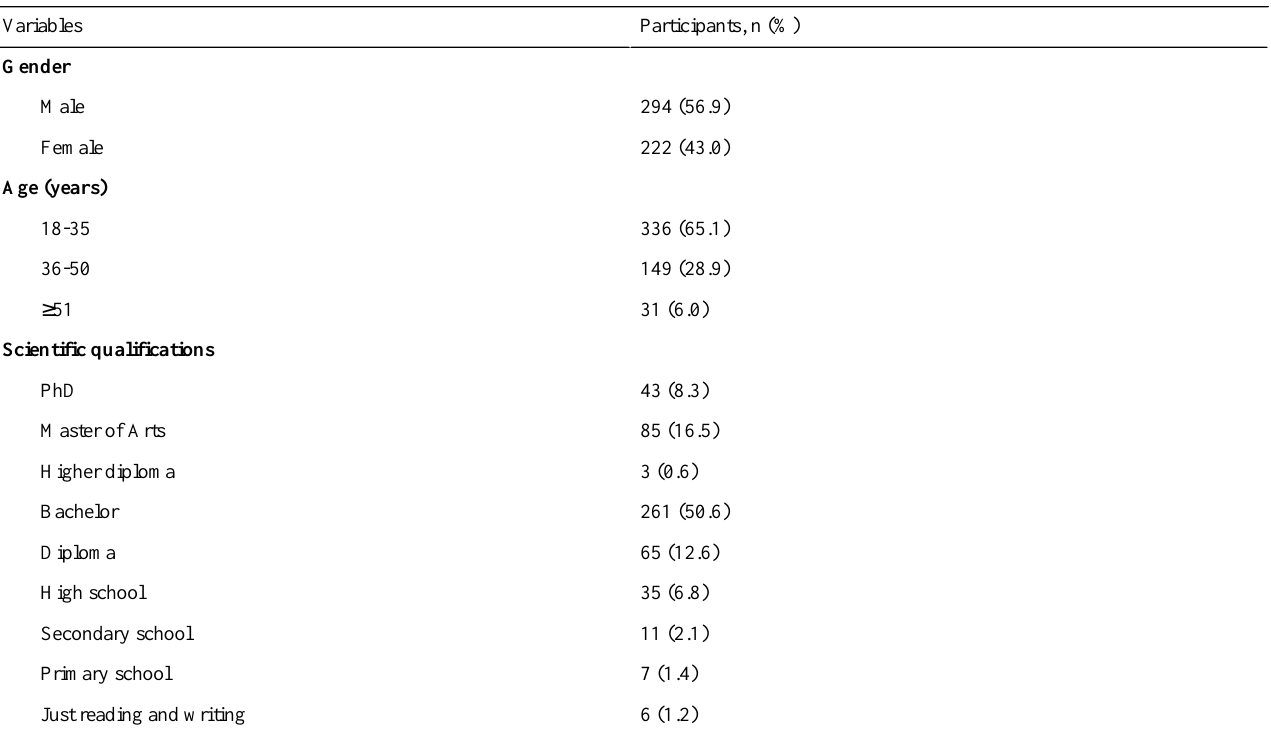
Table 1. Sociodemographic variables of study participants (N=516).